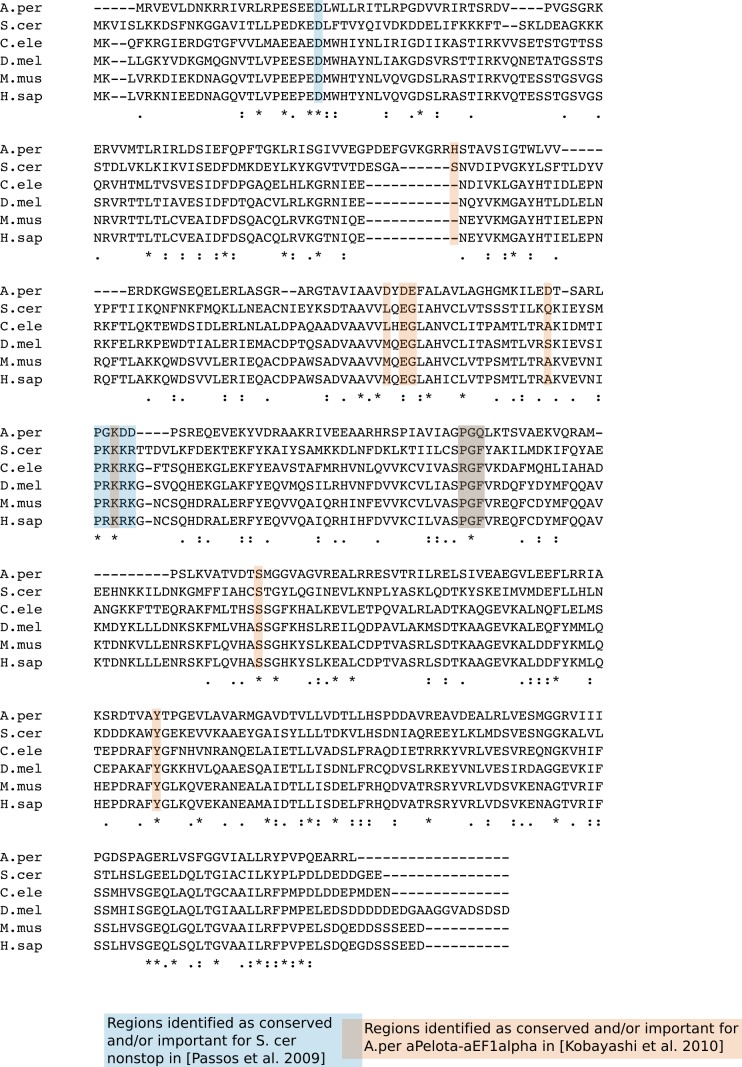
Multiple sequence alignment of C.elegans PELO-1 and sequence homologs.Sequences of dom34/pelota homologs were M. musculus (AAH57160.1), D. melanogaster (NP_476982.1), H. sapiens (BAG51633.1), Aeropyrum pernix (3WXM_B), C. elegans (R74.6/PELO-1), and S. cerevisiae (Dom34p). Multiple sequence alignment generated with Clustal Omega, and residues highlighted in blue/red indicate conserved and/or functional residues based on prior studies (Passos et al., 2009; Kobayashi et al., 2010).